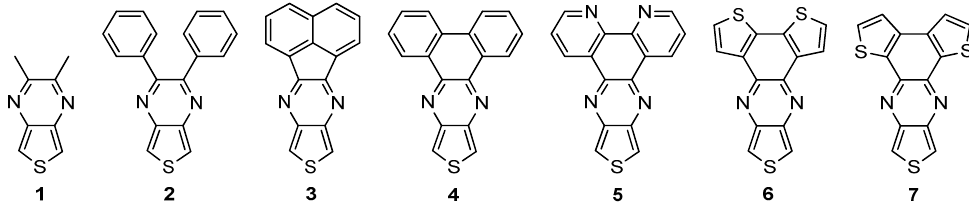
Figure 2. Representative thieno[3,4- b ]pyrazines ( 1 , 2 ) and extended fused-ring analogues ( 3 – 7 ).